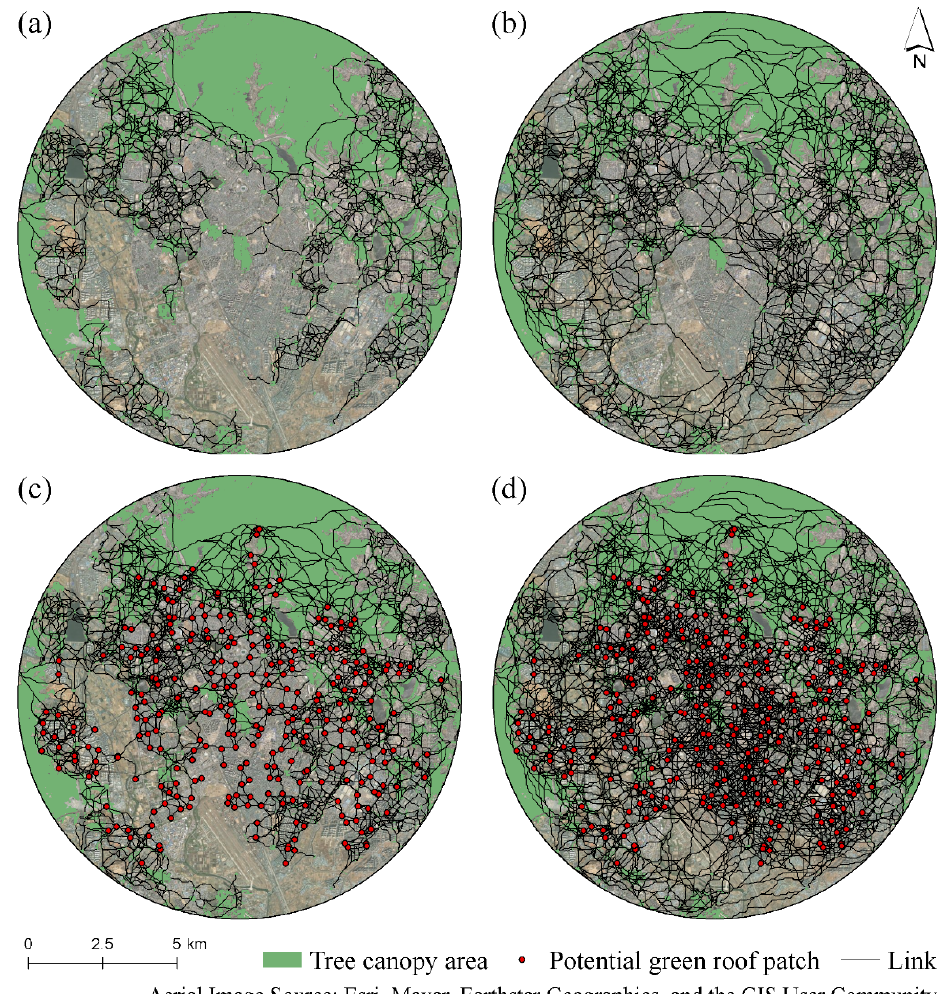
Figure 4. Current networks of tree canopy areas (nodes) connected by least-cost links at distance thresholds of ( a ) 3981 and ( b ) 13,290 cost units for the local and landscape scales, respectively, in Suwon City, Republic of Korea. ( c , d ) indicate changes in the tree canopy area network when adding potential green roof patches as nodes, connected by least-cost links at a distance threshold of 3981 and 13,290 cost units for the local and landscape scales, respectively.